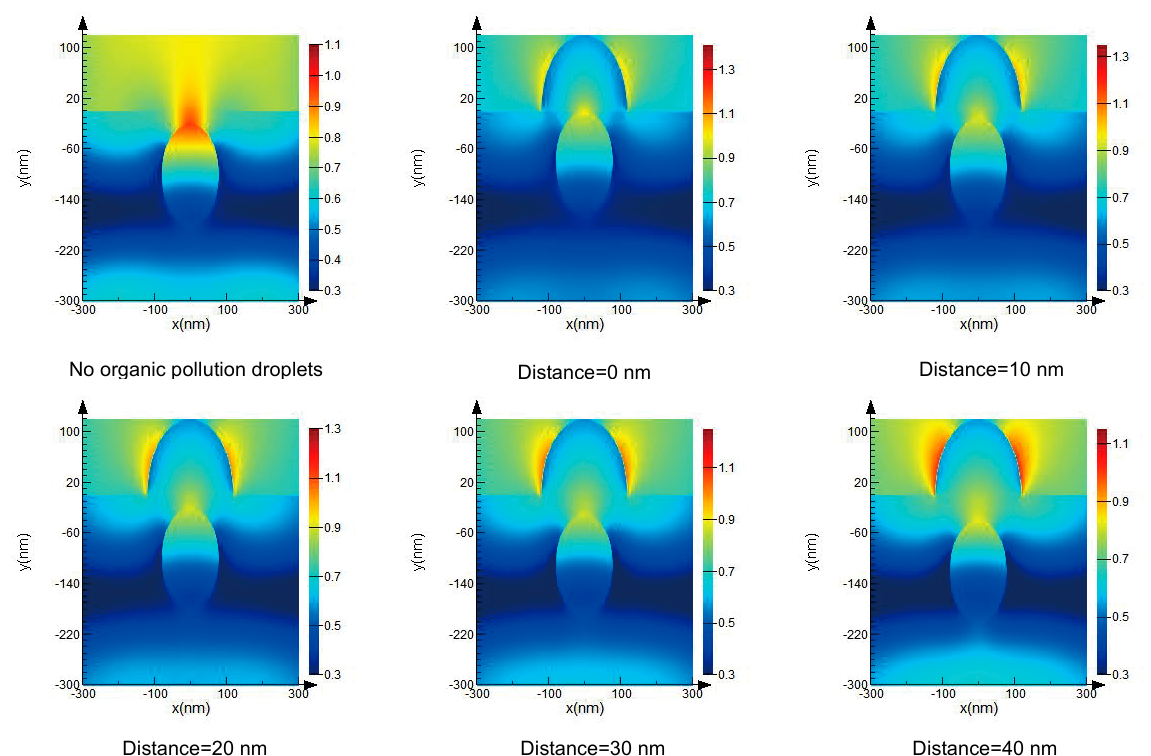
Figure 3. Light field enhancement with different coupling distances between a defect and an organic contamination droplet.